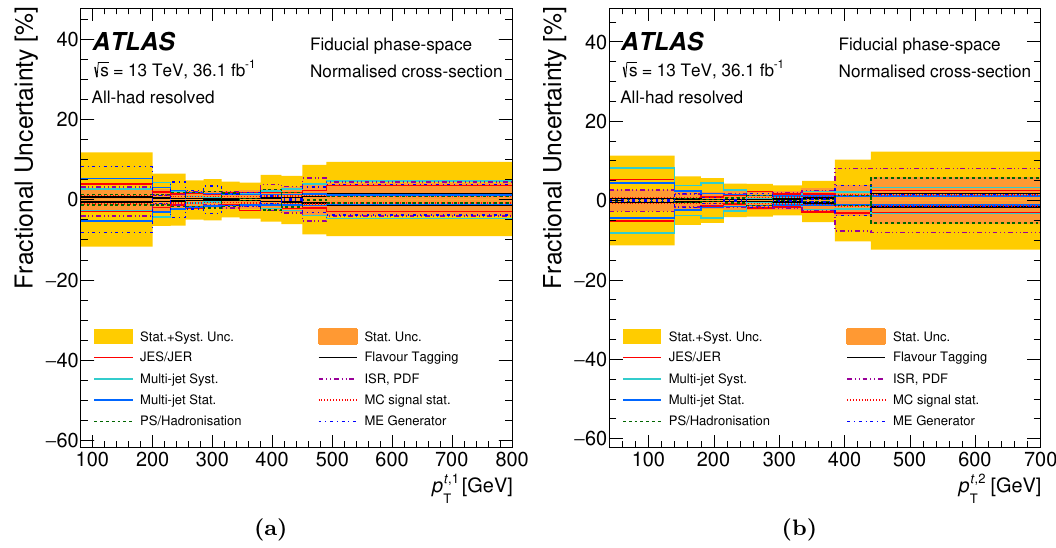
Figure 6 . Fractional uncertainties for the normalised single-differential distributions unfolded at particle level as a function of the (a) leading and (b) sub-leading top-quark transverse momenta. The bands represent the uncertainties in the unfolded data. Lines indicate the breakdown of the major components of the uncertainties.